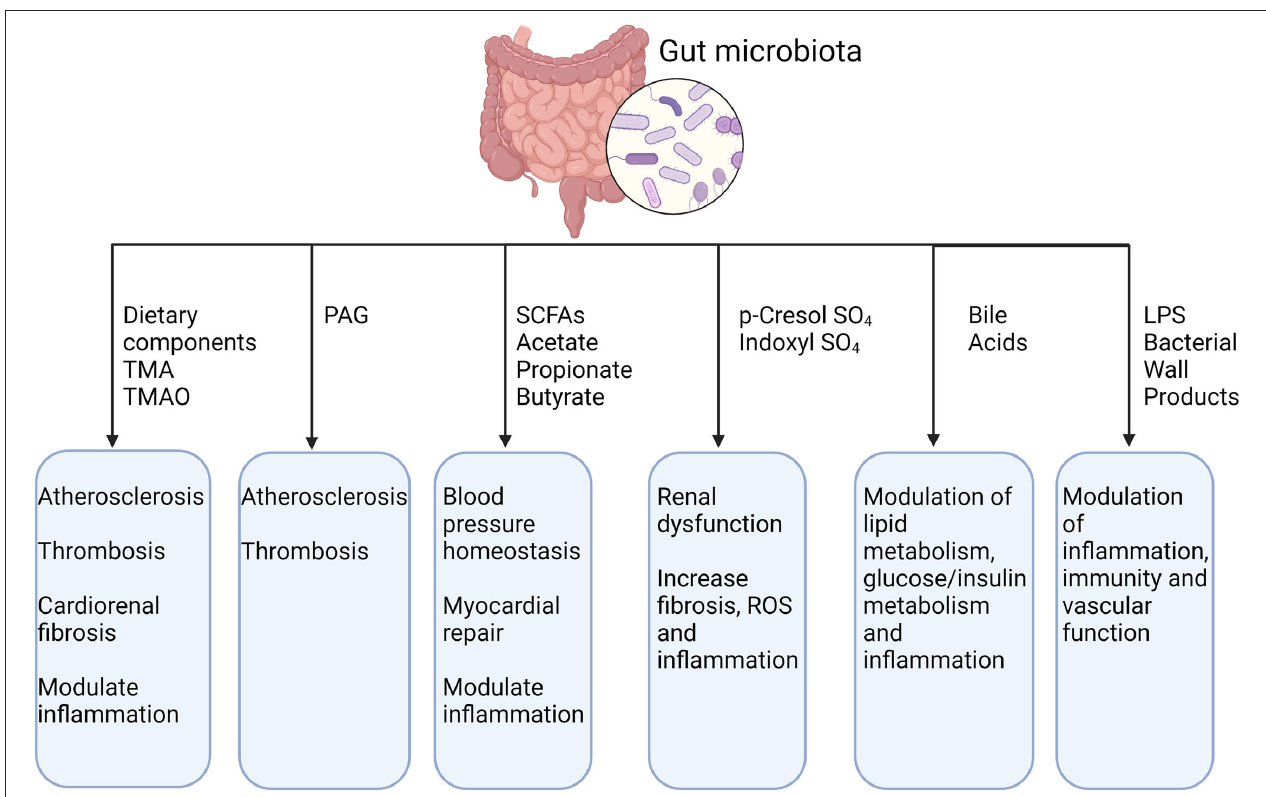
FIGURE 2 | Gut microbiota, its metabolites and their effect on CVDs. TMA, trimethylamine; TMAO, trimethylamine N-oxide; PAG, phenylacetylglutamine; SCFAs, short-chain fatty acid; LPS, lipopolysaccharide. Created with BioRender.com (Last accessed on 16 January